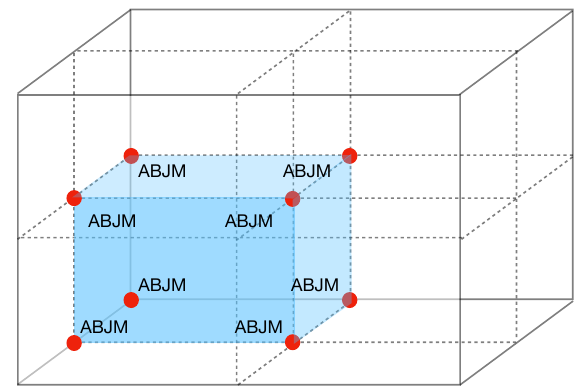
Figure 5 . The moduli space of T [ M 3 ; G ] with M 3 = T 3 and G = SU (2). Shown here is the real slice of the space C (cid:3) (cid:2) C (cid:3) (cid:2) C (cid:3) , a three-dimensional \pillowcase." The eight ABJM theories are at the Z 2 eight corners of the